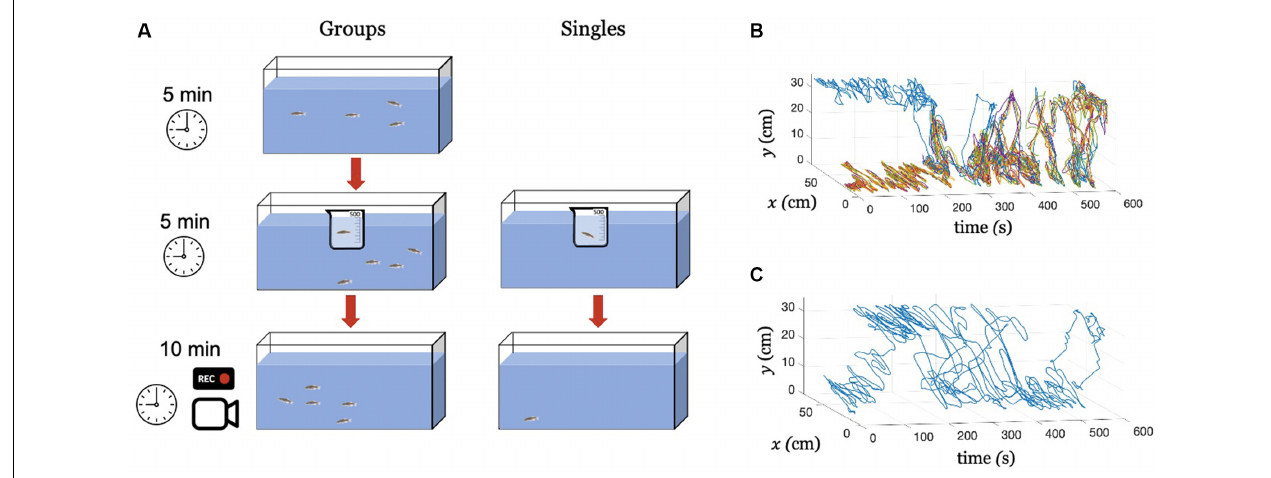
FIGURE 1 | Experimental procedure and tracking. (A) An illustration of the experimental procedure for conditions Groups and Singles. Exemplary tracked swimming trajectories over time, (B) Condition Groups, where the blue color identifies the treated individual and all the other colors the untreated subjects, and (C) Condition Singles, where the blue color identifies the treated